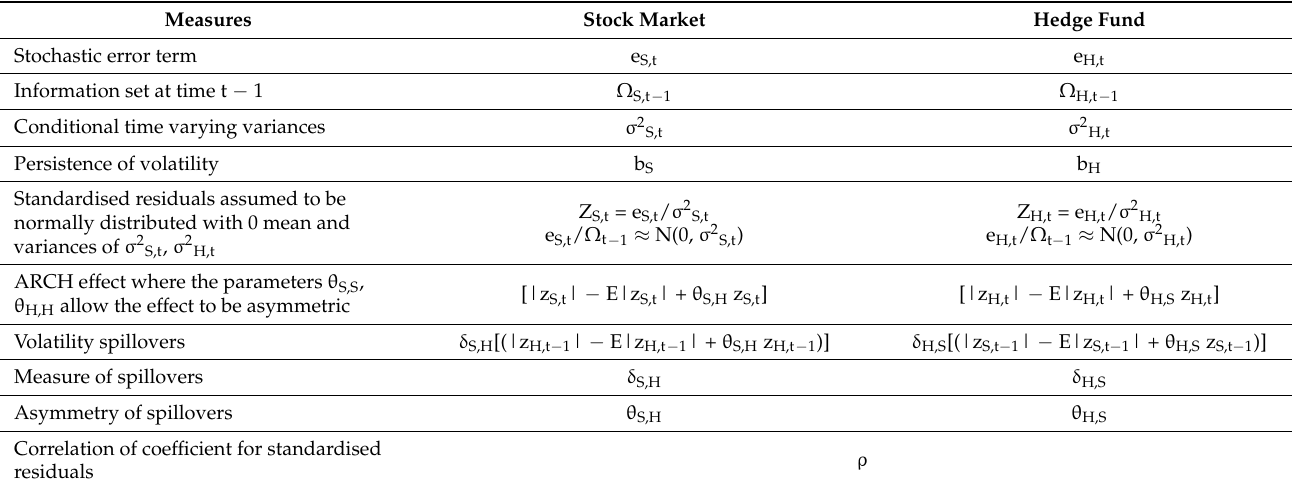
Table 1. Description of Model